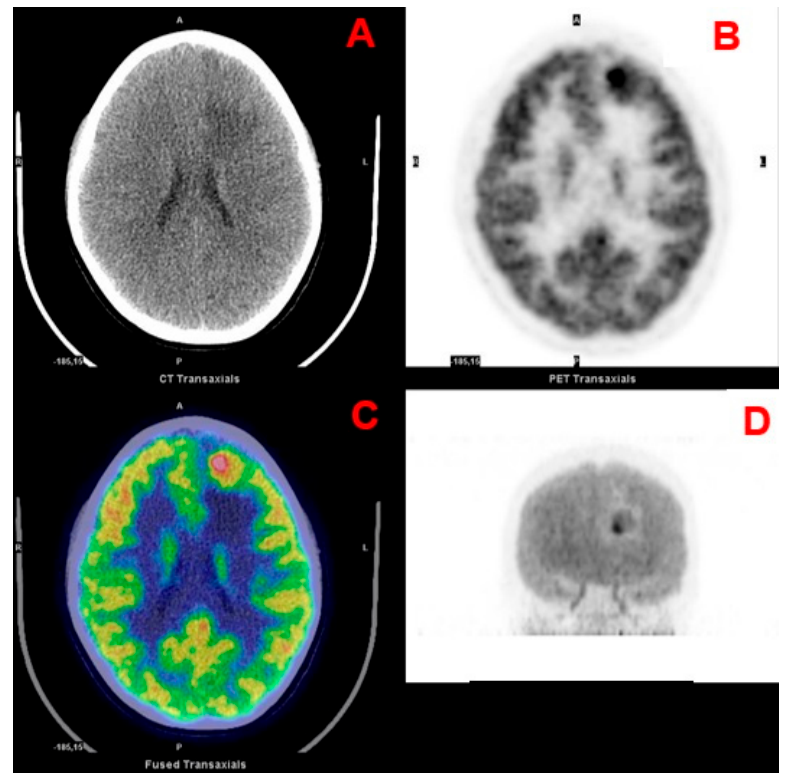
Figure 3. Transaxial CT ( A ), PET ( B ) and fused PET/CT ( C ) and maximum intensity projection ( D ) images of a frontal ganglioglioma.